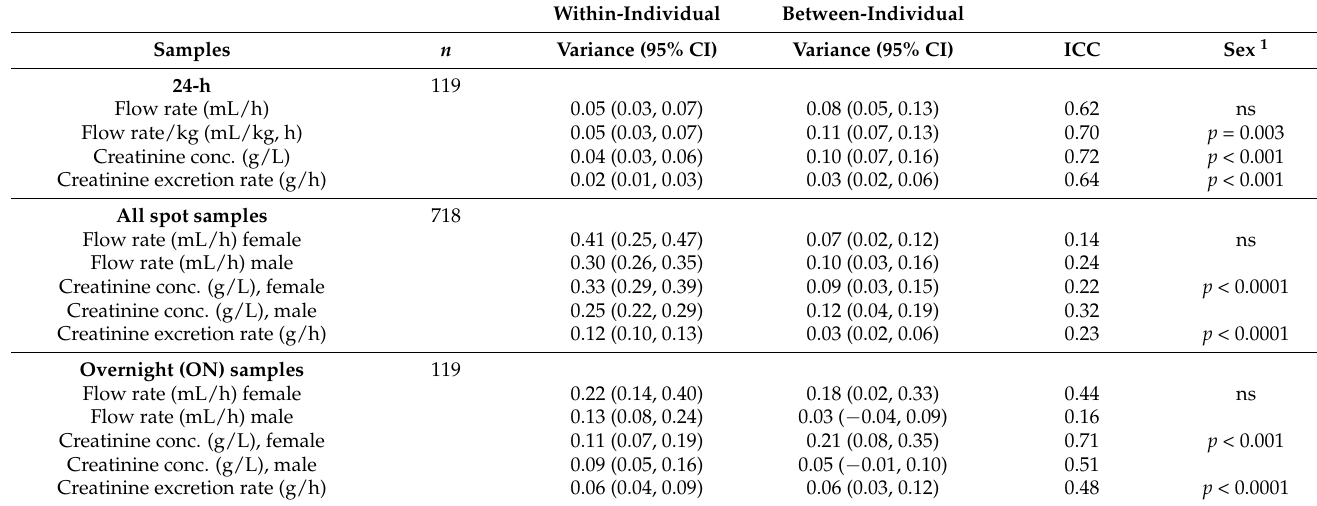
Table 3. Within- and between-individual variance (with 95% confidence interval (CI)) and intra-class correlation (ICC) for urinary flow rate and creatinine for different sampling